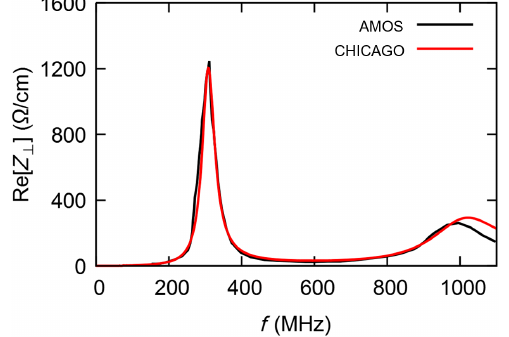
FIG. 12. Z ⊥ as a function of frequency for ETA-II cell. Black: AMOS results from Ref. [12]. Red: CHICAGO simulation results.